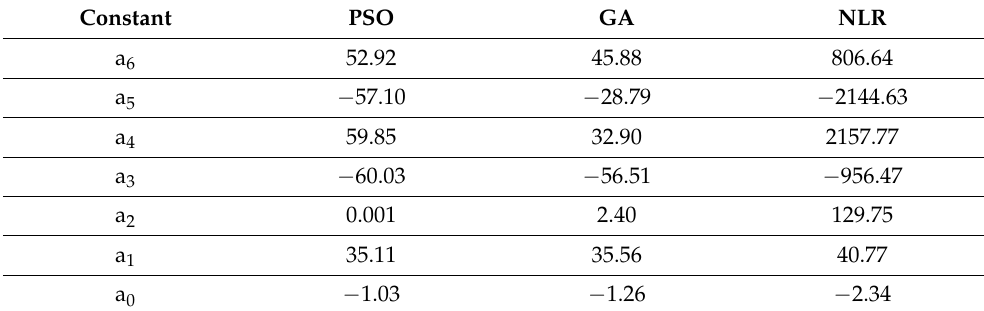
Table 7. Values of unknown constants found by PSO, GA, and NLR for throttle estimation.